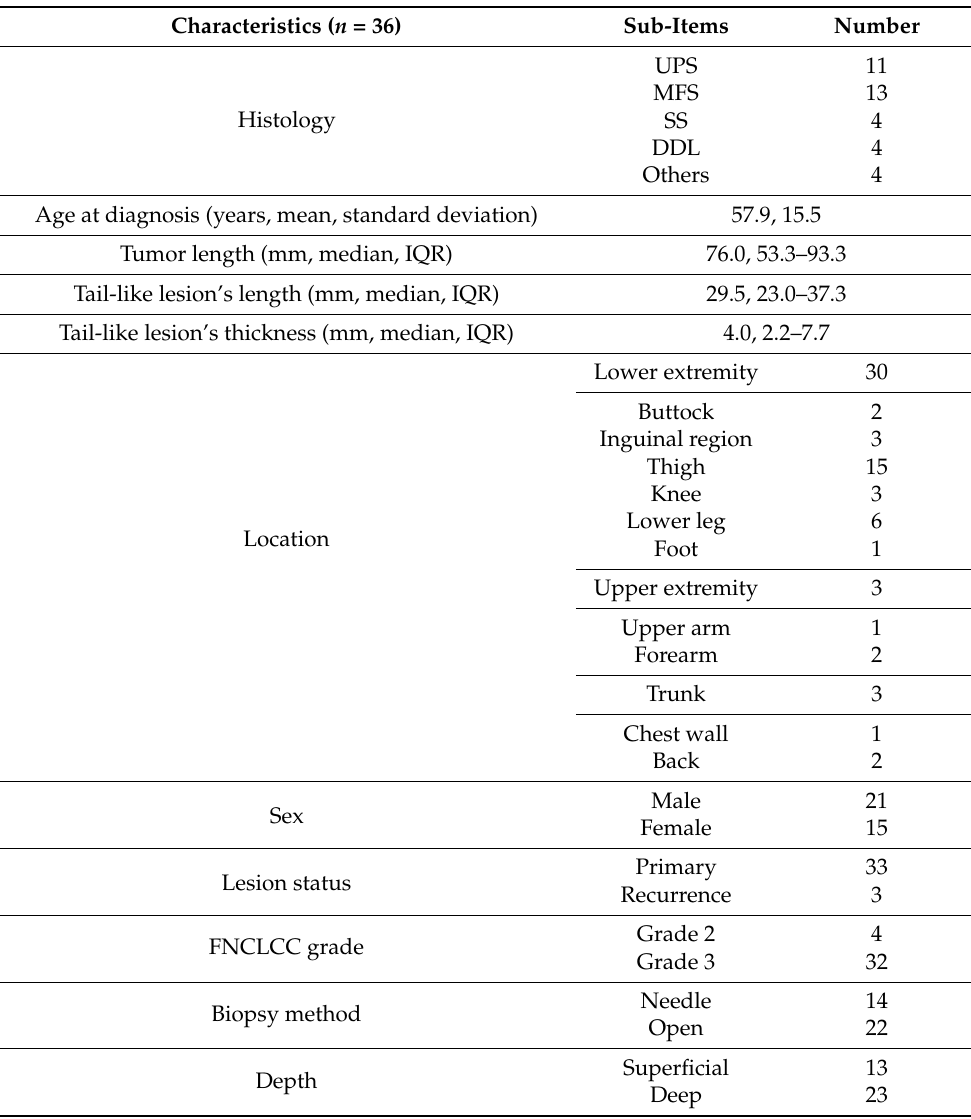
Table 1. Characteristics of patients with a tumor with tail-like